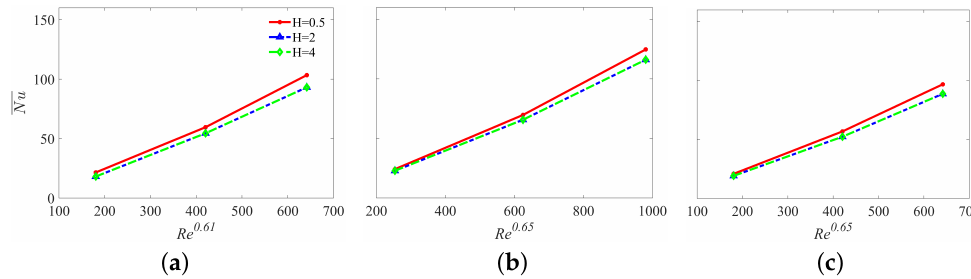
Figure 25. Nusselt number and Reynolds number scaling relationships for ( a ) Straight nozzle, ( b ) Converging nozzle, and ( c ) Diverging